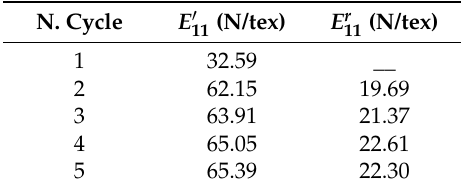
Table 6. Values of predicted modulus and experimental